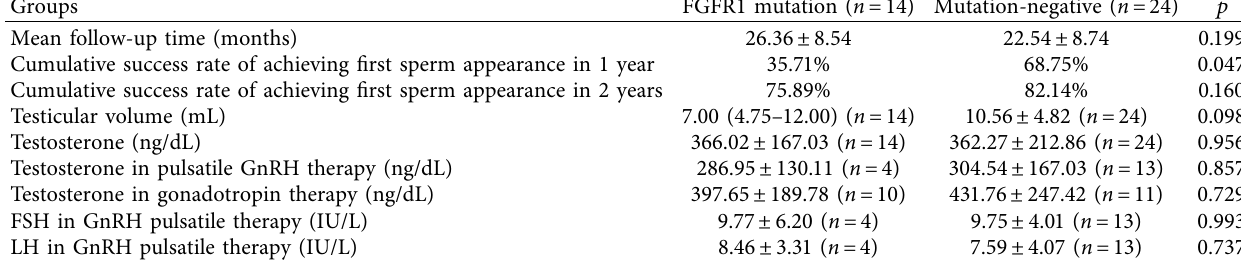
Table 3: Sperm production during therapy.